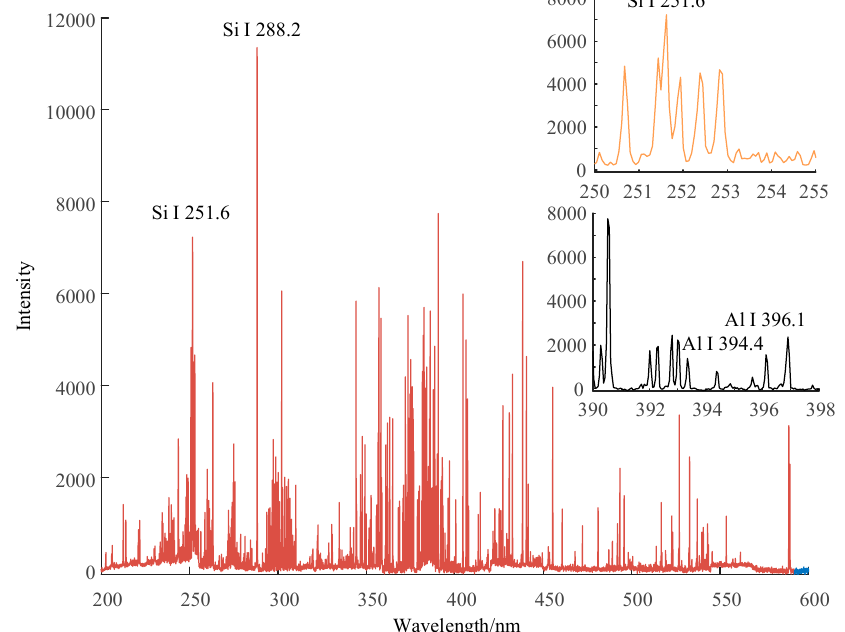
Figure 8. Emission spectrum of new silicone rubber with no ATH filler, while the mass fraction of silica filler is 0.3.